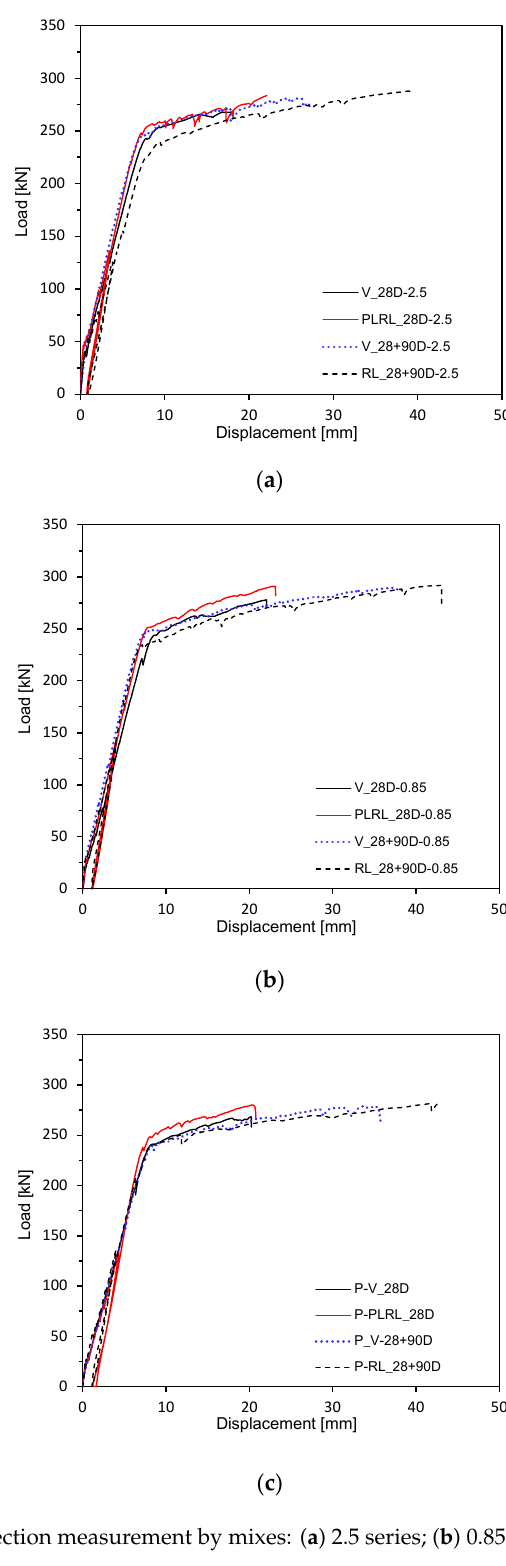
Figure 9. Load-deflection measurement by mixes: ( a ) 2.5 series; ( b ) 0.85 series; ( c ) Plain series.